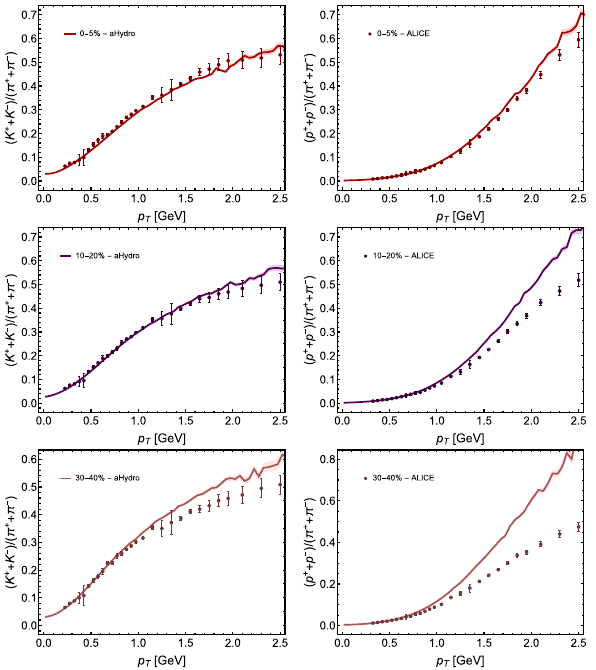
Fig. 3 The K /π (left) and p /π (right) ratios as a function of p T mea- sured in Pb–Pb collisions at 5.02 TeV in different centrality classes. Solid lines are predictions of aHydroQP model where symbols with error bars are experimental data from Ref. [69]